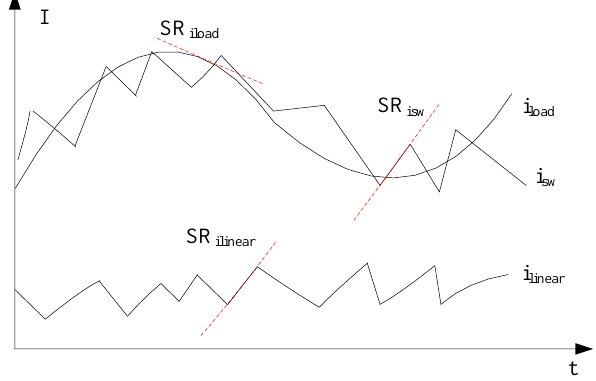
Figure 3. The key waveform of current through a hybrid power modulator.